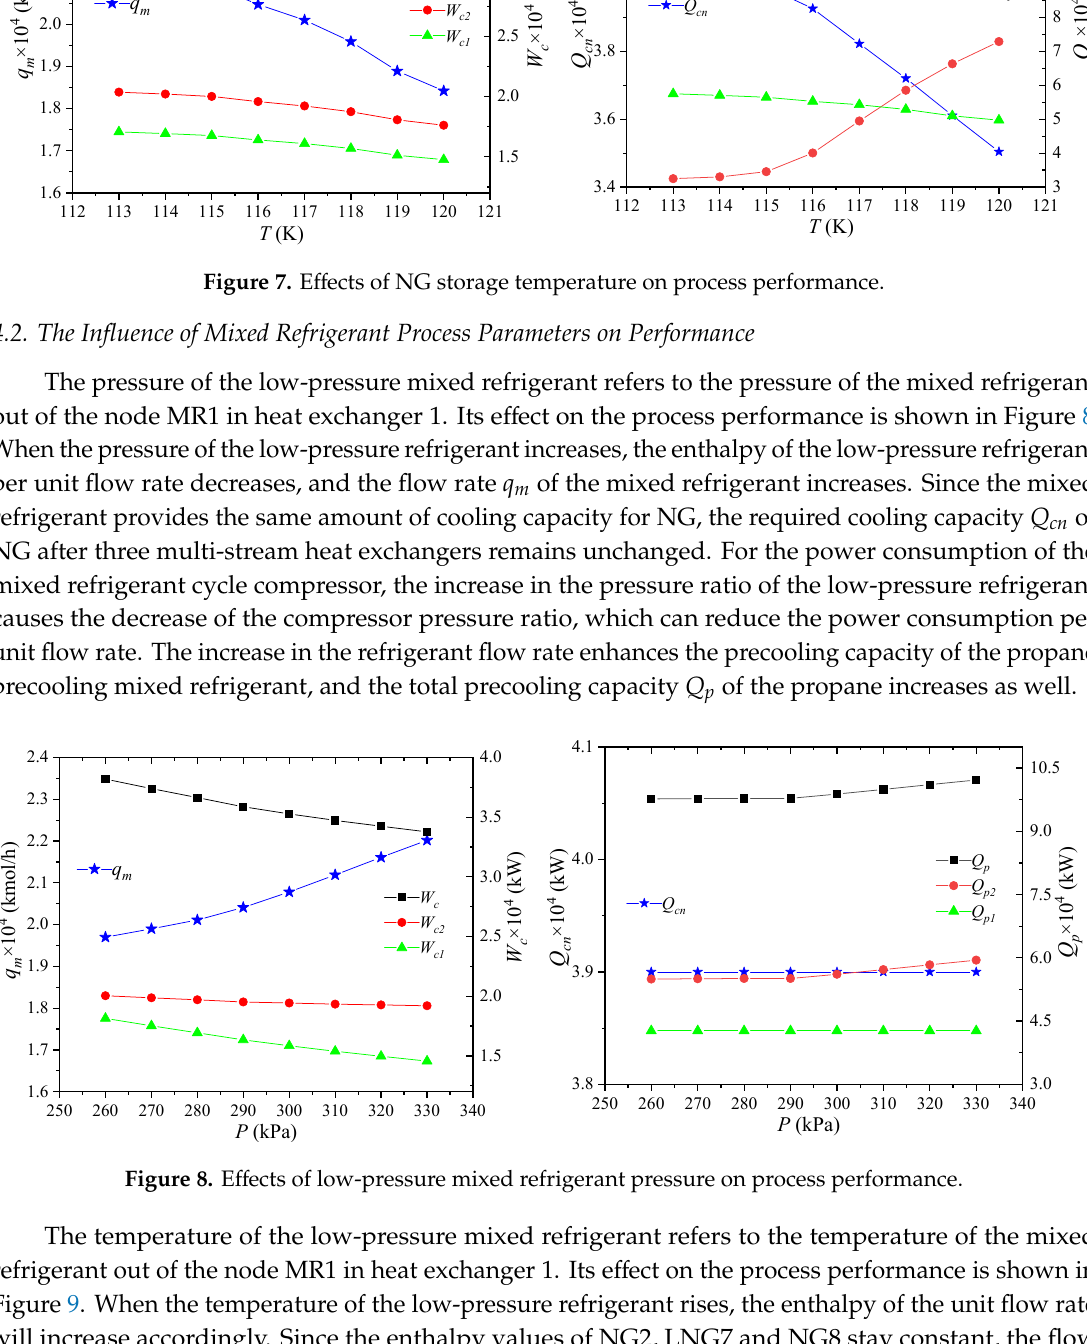
Figure 8. Effects of low-pressure mixed refrigerant pressure on process performance.